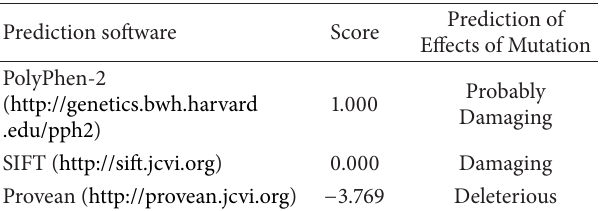
Table 3: In silico prediction of the effects of the p.R141Q mutation in CYP11B1